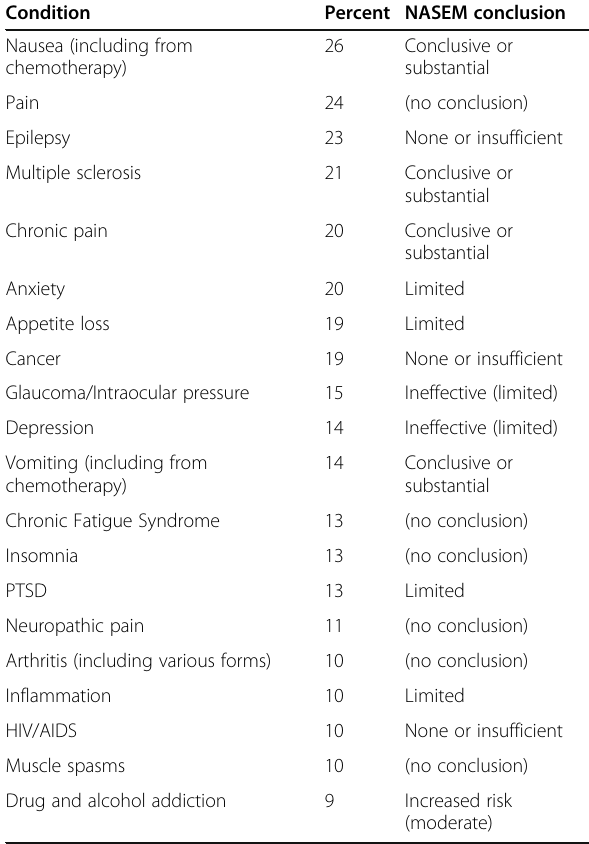
Table 1 Health and medical conditions recommended for cannabis treatment on 179 identified websites and corresponding conclusions from the National Academies